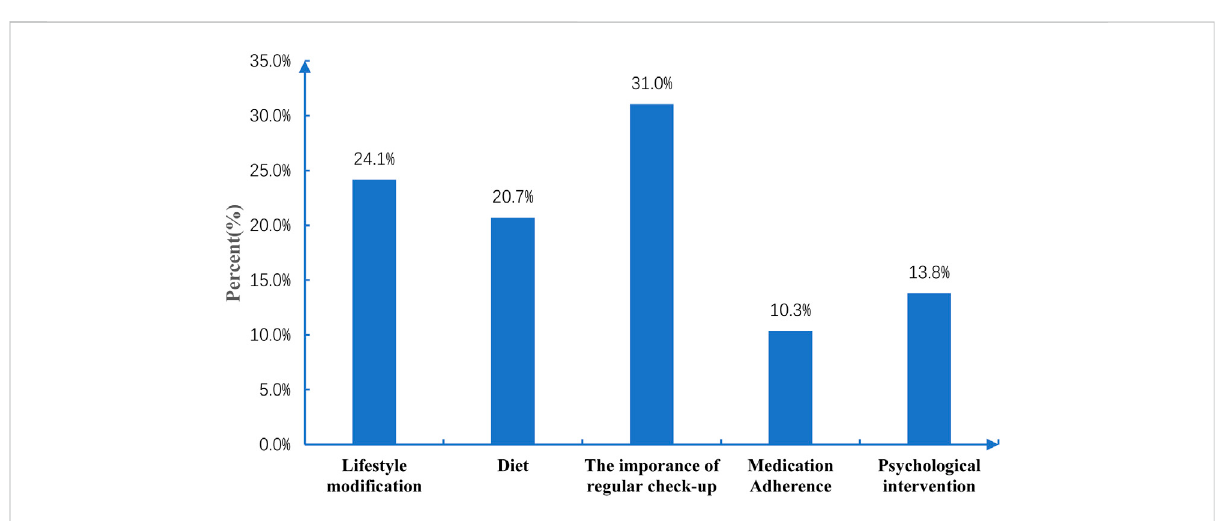
FIGURE 2 Percentages of non-pharmacological recommendations for